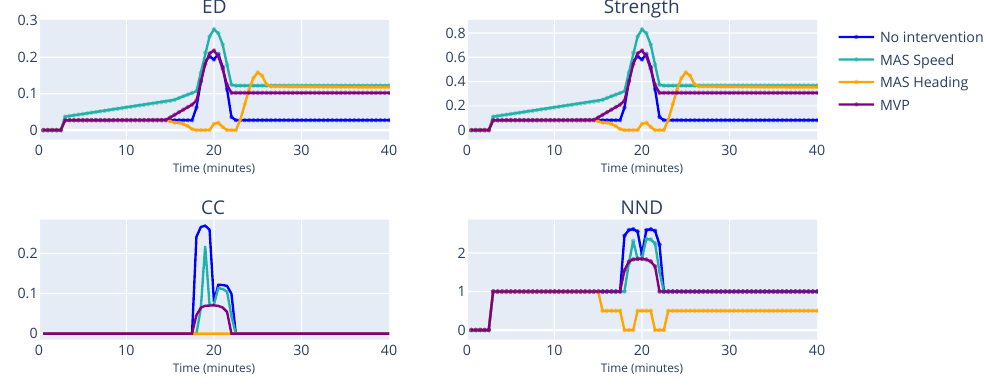
Figure 12. Miles-in-Trail with 4 aircraft per